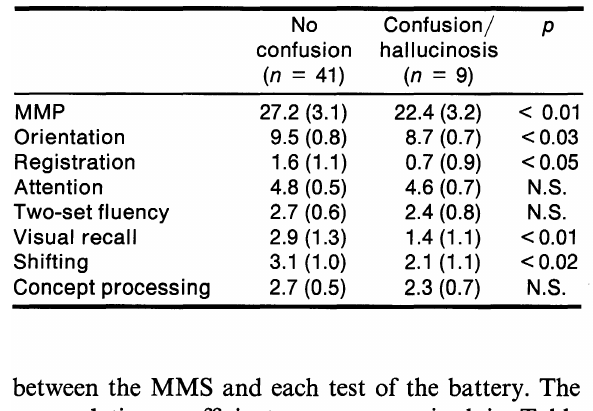
TABLE IV. Construct validity. Comparison of MMP and subsection scores according to history of confusion/hallu cinosis with level of significancy (p) for Student's t-test (for MMP total score) and Mann-Witney U test (for subsections). Values are expressed as means